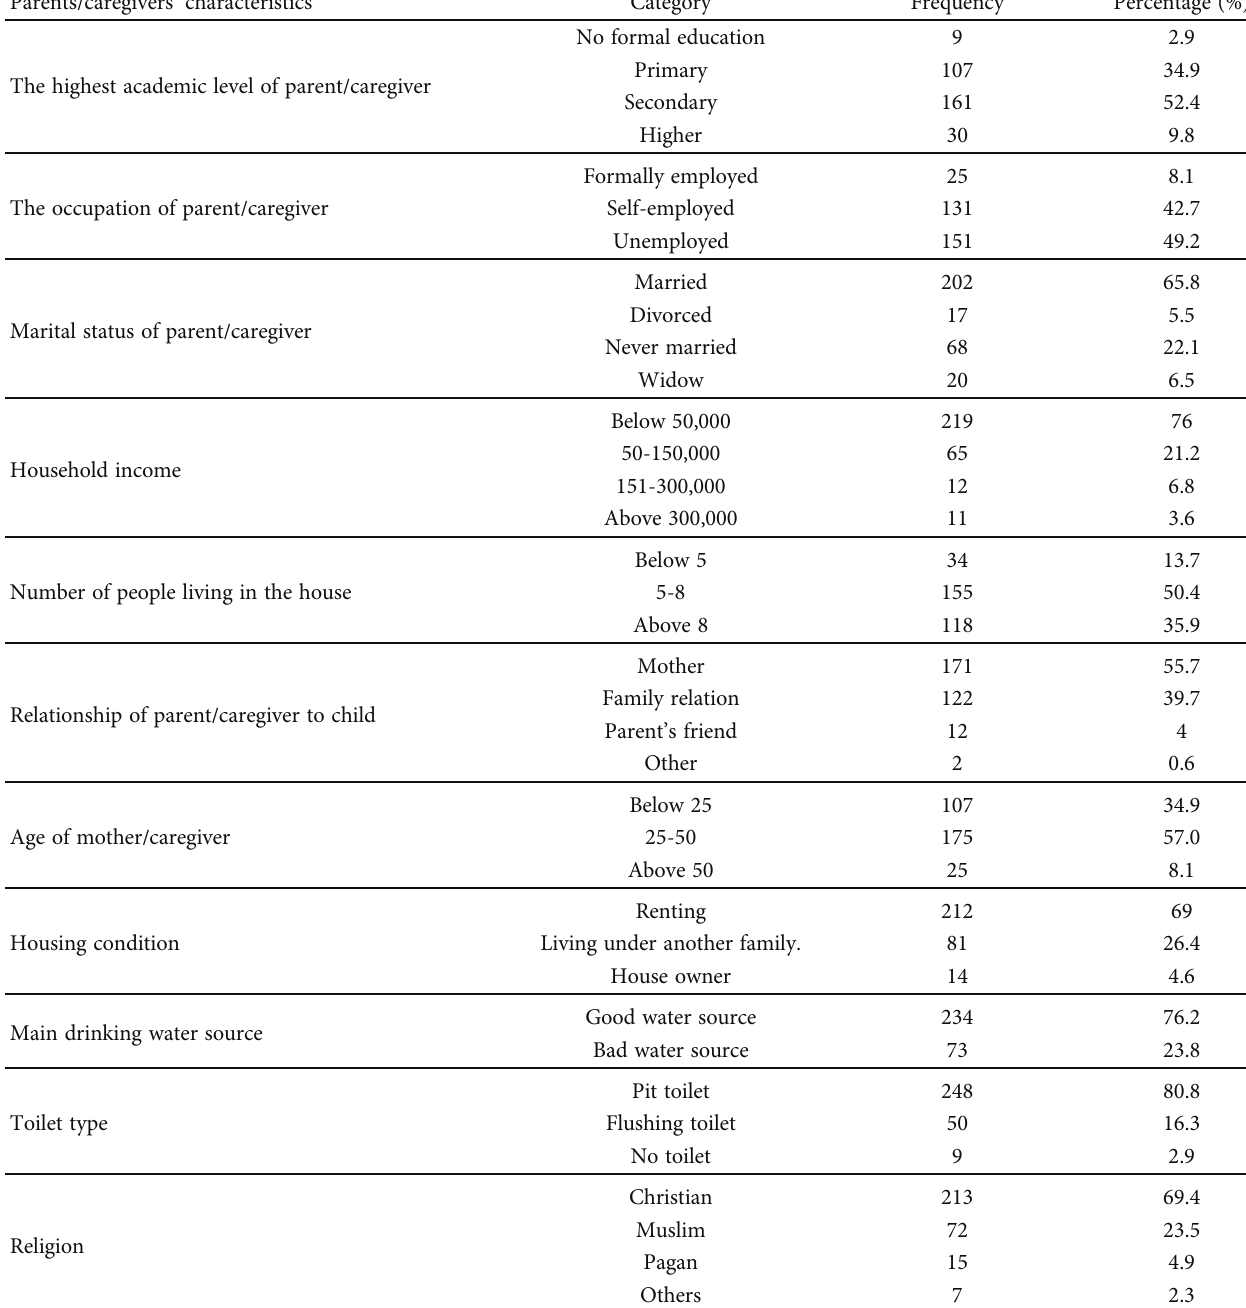
Table 2: Demographic characteristics and socioeconomic status of the